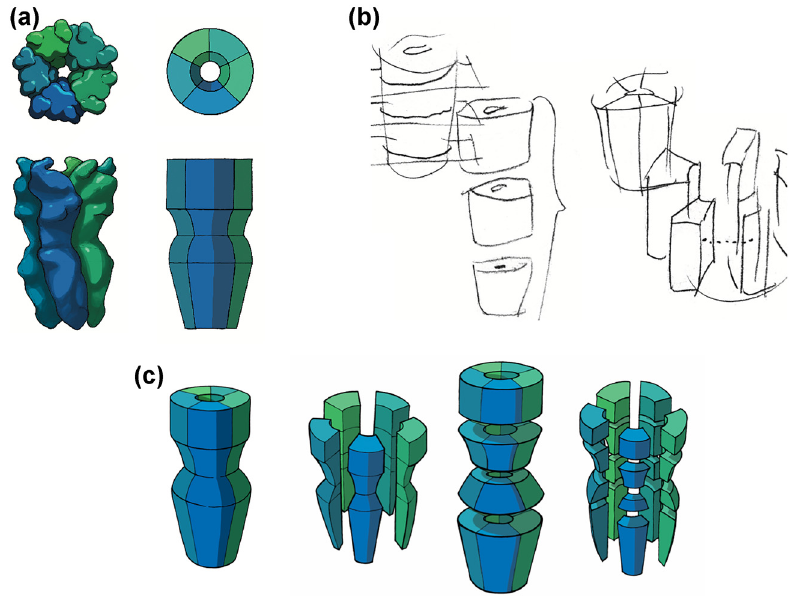
Figure 2: Simplification and decomposition of molecular structure.